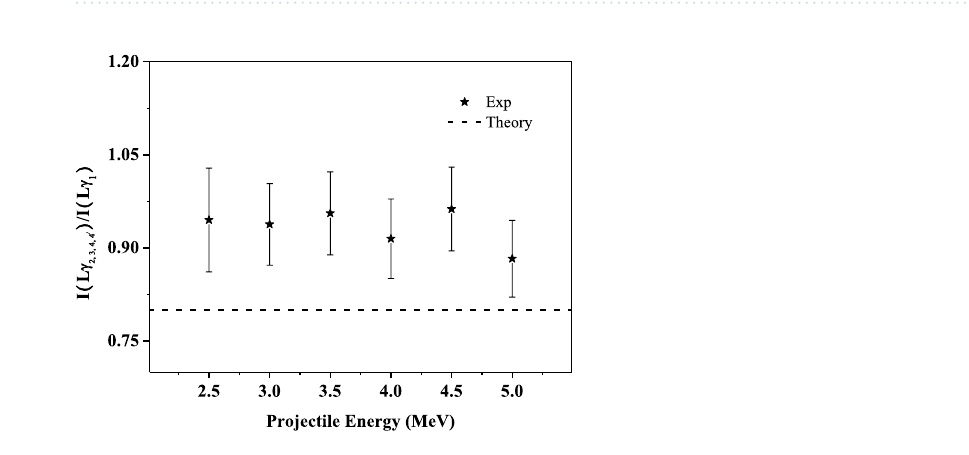
Figure 7. Relative intensity ratios of I Lγ 2, 3, 4, 4 ’ to Lγ 1 X-ray as a function of incident